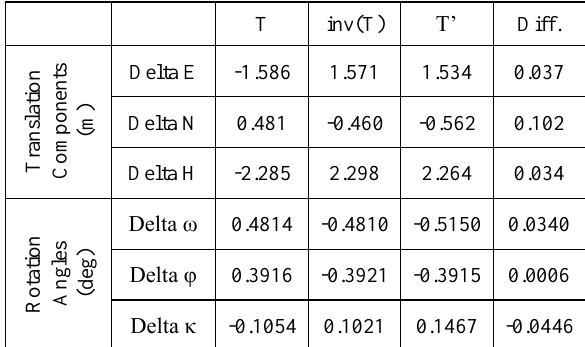
Figure 16. The skeleton for Block 3 obtained thanks to manual segmentation